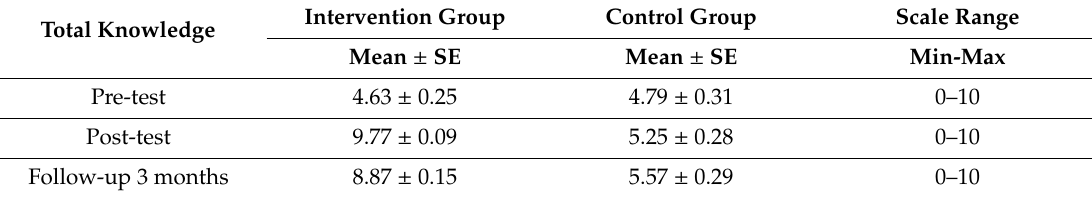
Table 2. Mean and standard deviation of the students’ total knowledge responses in intervention